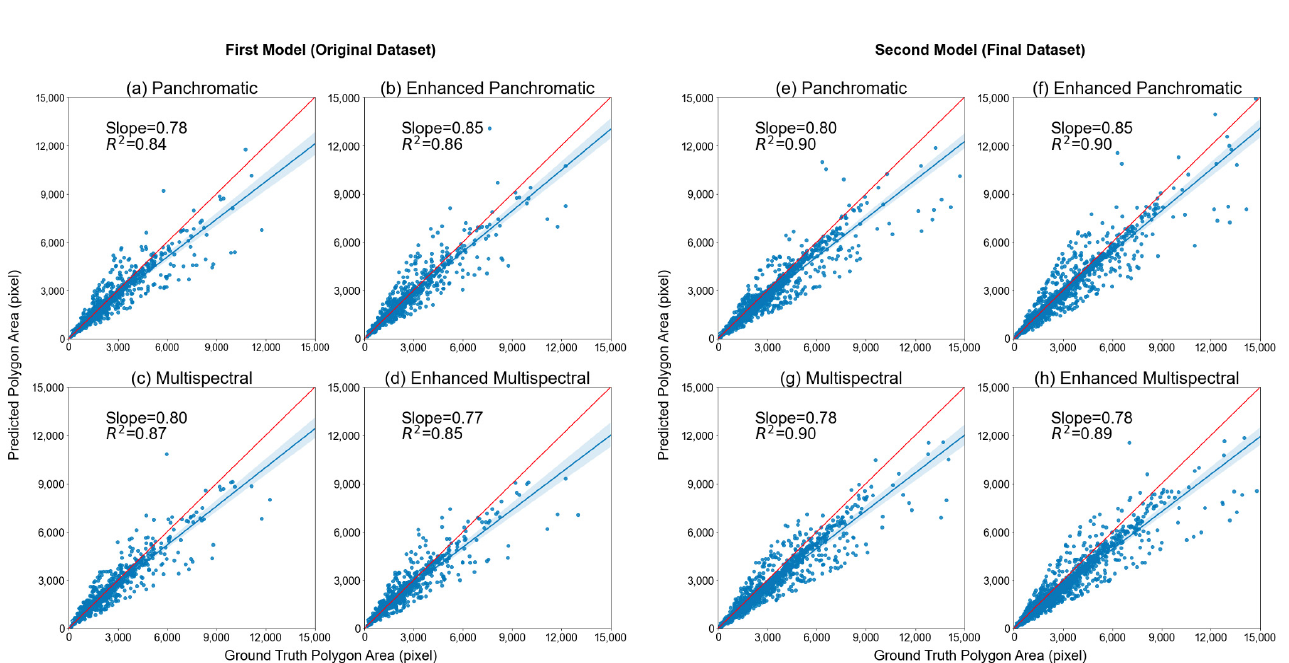
Figure 4. Scatterplots of ground truth mask area (in pixels) on the x -axis versus delineated mask area (in pixels) on the y -axis. Only correctly delineated field masks are included. Plots ( a – d ) represent results for the original model across WV-3 image types in Bihar, and plots ( e – h ) represent results for the final model across WV-3 image types in Bihar. Blue lines with shading represent the linear regression line with 95% confidence intervals, and red lines represent the one-to-one